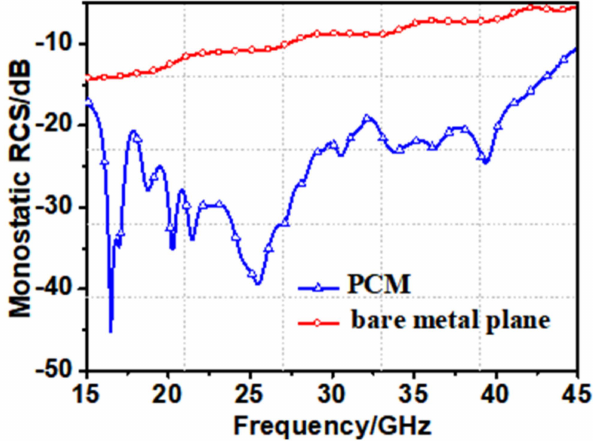
Figure 9. The simulated realize radar cross section (RCS) for the 3-bit coding metasurface and a bare metal plate with the same